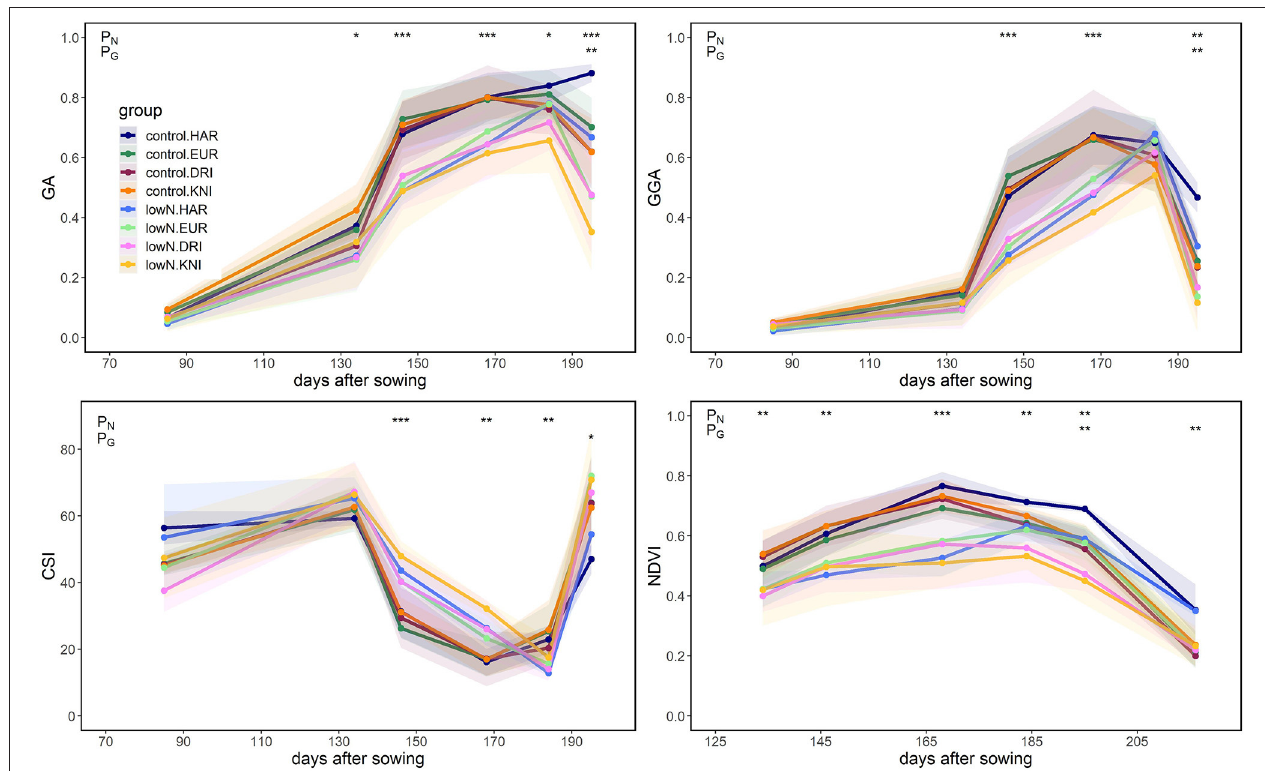
FIGURE 3 | Green area (GA), greener green area (GGA), crop senescence index (CSI), and normalized difference vegetation index (NDVI) in four varieties of field-grown durum wheat (Kiko Nick, Don Ricardo, Euroduro, and Haristide) at two N levels (control vs. low N) measured at the canopy level. Asterisks indicate a significant difference between varieties (G) and N levels (N) according to the two-way ANOVA(*, p < 0.05; **, p < 0.01; ***, p < 0.001). The interaction G × N did not reach significance for these parameters.